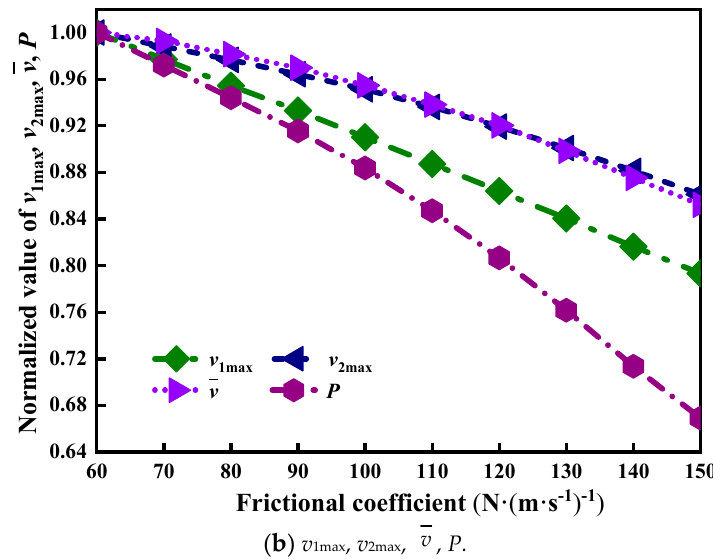
Figure 7. Variation of performance parameters with frictional coefficient.